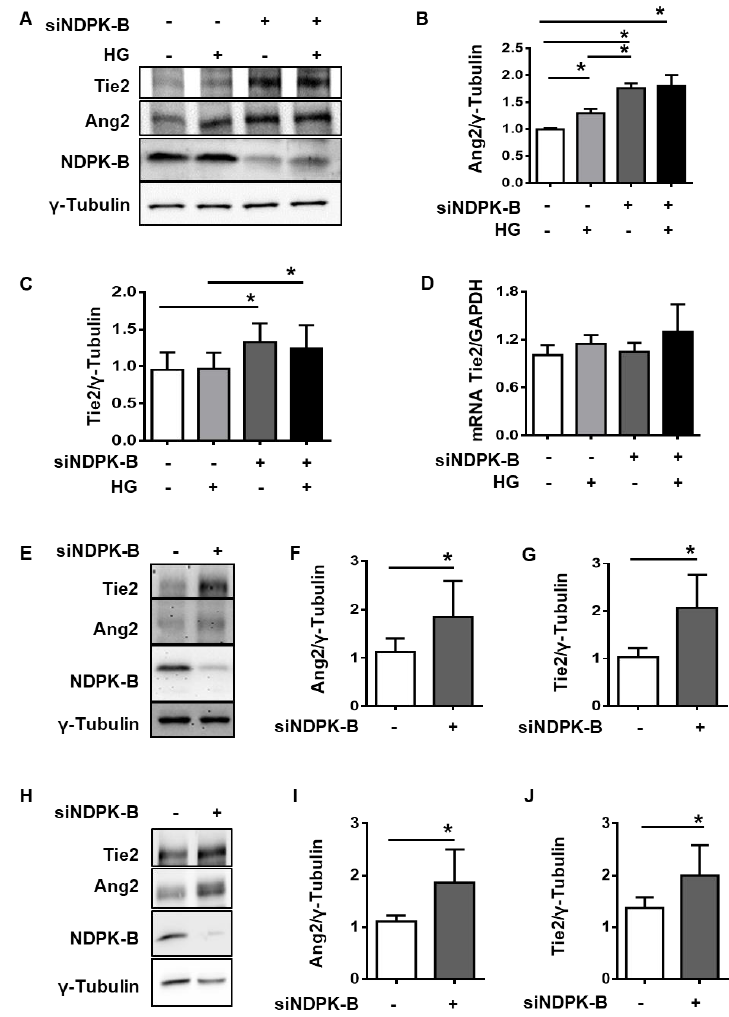
Figure 2. NDPK-B depletion upregulates Ang2 and Tie2 in endothelial cells. ( A ) HUVECs were transfected with either scrambled control ( − ) or siRNA against NDPK-B (siNDPK-B, + ). ( A ) Representative immunoblots of Tie2, Ang2, NDPK-B, and γ -Tubulin in NDPK-B depleted HUVECs treated for 24 h without ( − ) or with HG, ( + ). Quantification of Ang2 ( B ) and Tie2 ( C ) levels, ( n = 4). ( D ) Tie2 mRNA expression normalized to glyceraldehyde 3-phosphate dehydrogenase (GAPDH) mRNA ( n = 4). HMECs and HRMVECs were transfected with either scrambled control ( − ) or siRNA against NDPK-B (siNDPK-B, + ). ( E ) Representative immunoblots of Tie2, Ang2, NDPK-B, and γ -Tubulin in HMECs. Quantification of Ang2 ( F ) and Tie2 ( G ) levels, ( n = 3). ( H ) Representative immunoblots of Tie2, Ang2, NDPK-B, and γ -Tubulin in HRMVECs. ( I , J ) Quantification of Ang2 ( I ) and Tie2 ( J ) levels, ( n = 5). All protein contents were normalized to γ -Tubulin. * p <